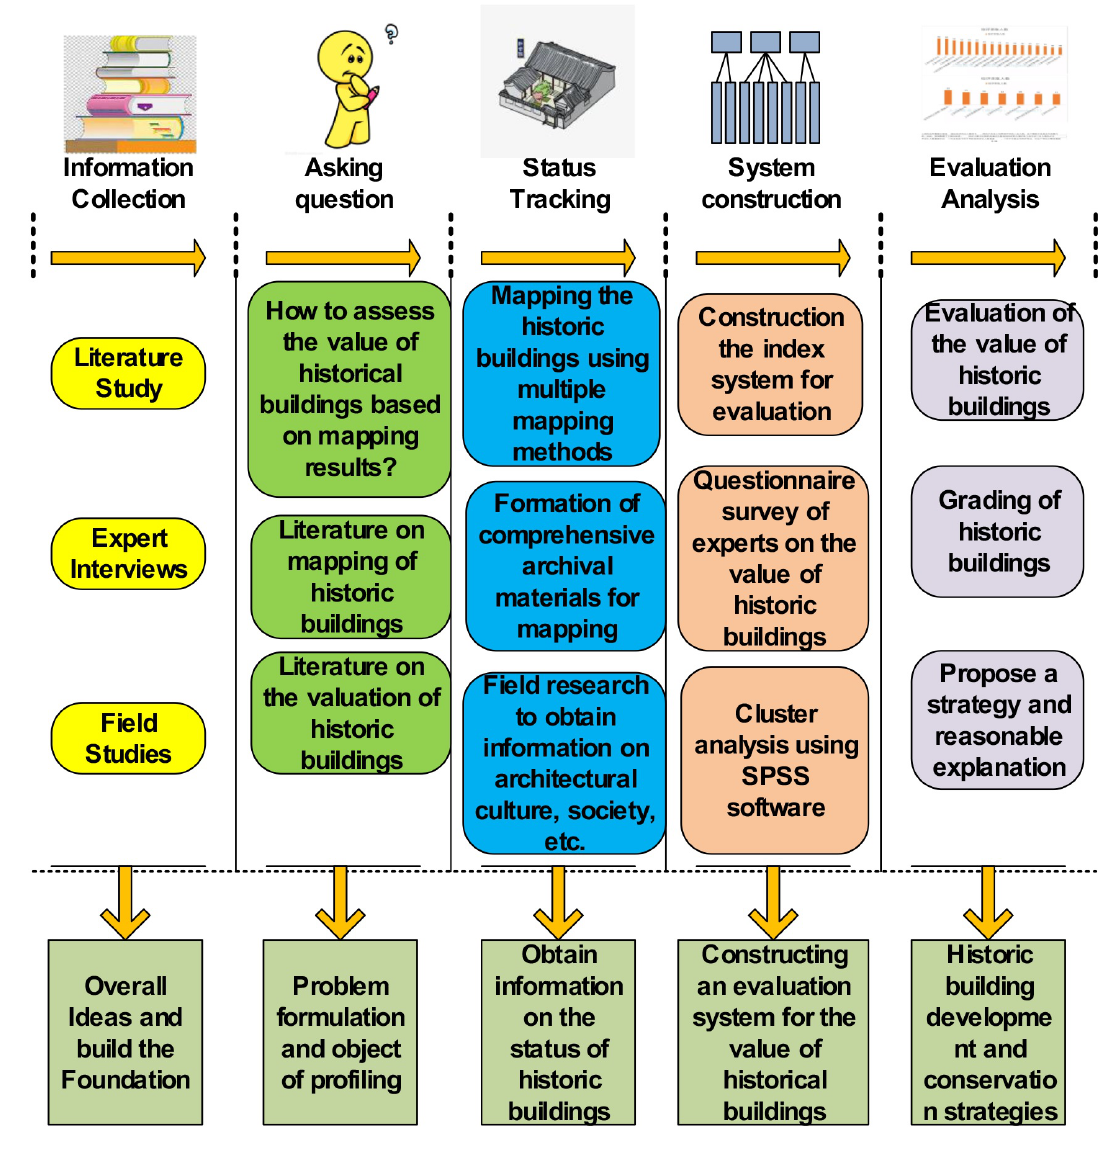
Fig. 1 Research technology